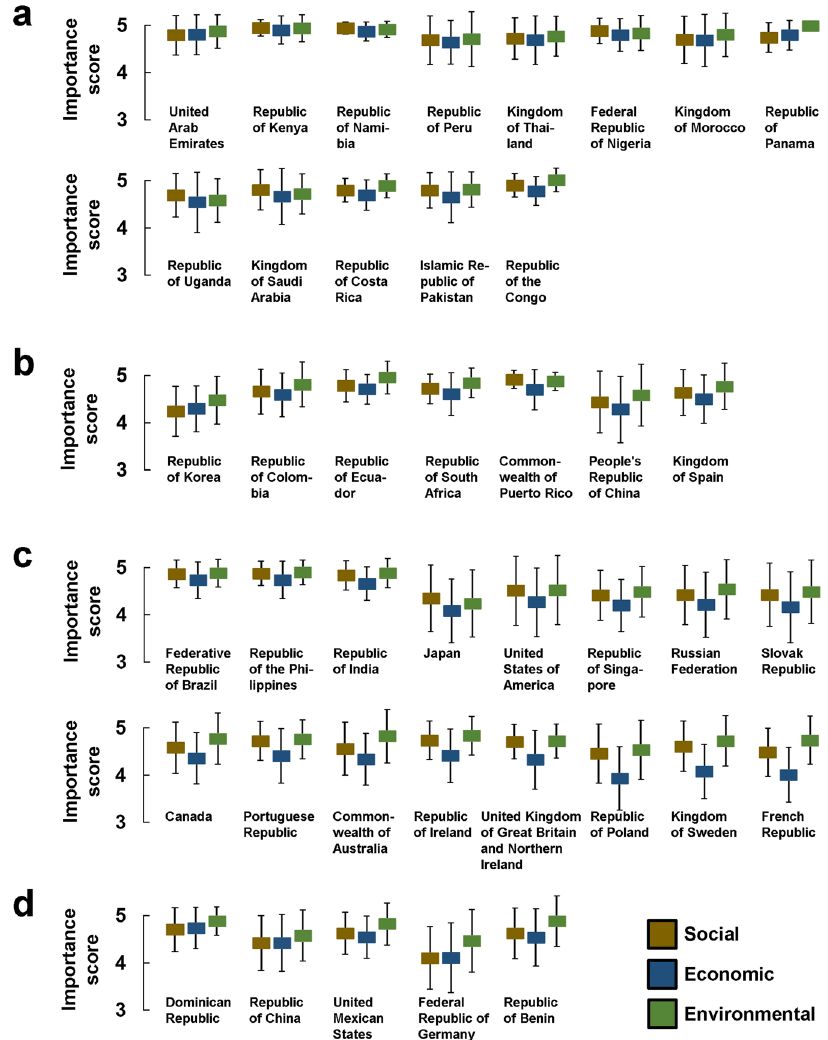
Fig. 1 Illustration of the three factors of the SDGs (social, economic, environmental) for each of the surveyed countries. In group ( a ), there are no signi fi cant differences between the three factors within the countries. In group ( b ), the environmental factor is rated higher than the economic factor but not higher than the social factor. In group ( c ), the economic factor is rated lower than the other two factors. In group ( d ), the environmental factor is rated signi fi cantly higher than both the economic and environmental factors. For clarity, the signi fi cance levels are not marked with asterisks in the fi gure. Exact signi fi cance levels and effect sizes can be found in Supplementary Table 1. The boxes represent the mean of the components; the error bars represent the standard deviation.